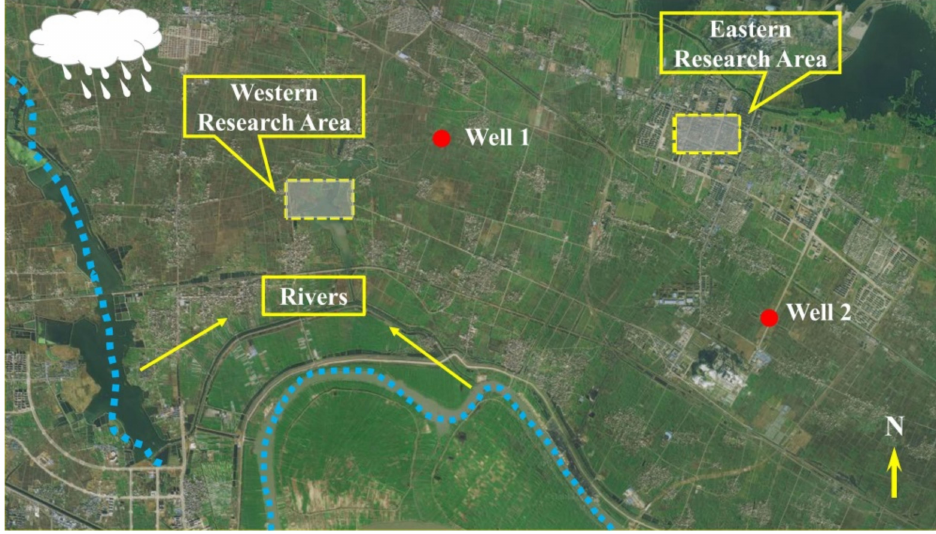
Figure 1. Determination of the decay rate constant according to Guggenheim’s